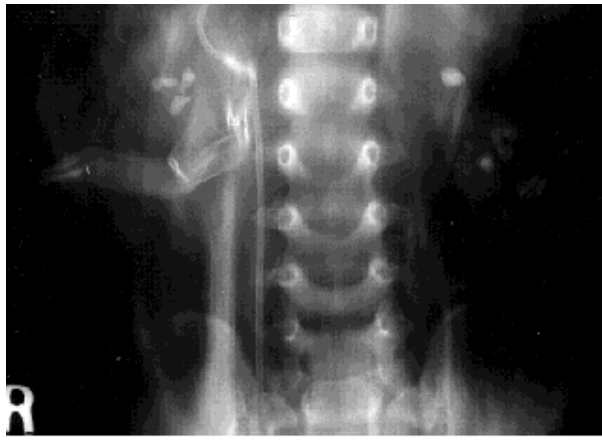
FIGURE 2a . Conventional radiograph demonstrates reduced stone burden following bilateral open surgery. Bilateral penrose drains and JJ ureteral stents in place.